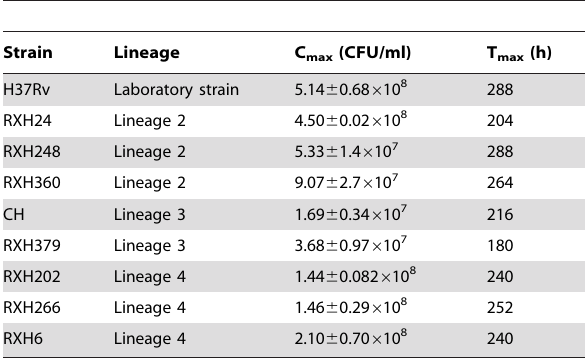
Table 2. Strain wise comparison of M. tuberculosis growth in axenic media based on Cmax # and Tmax # # values.